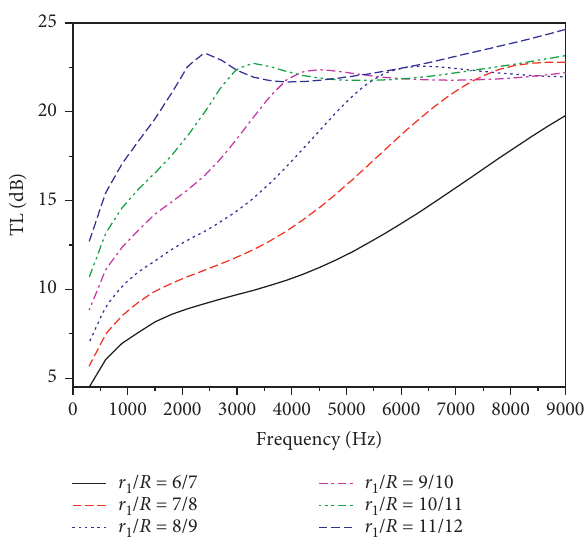
Figure 6: TL curves with different distances between two adjacent cavities.